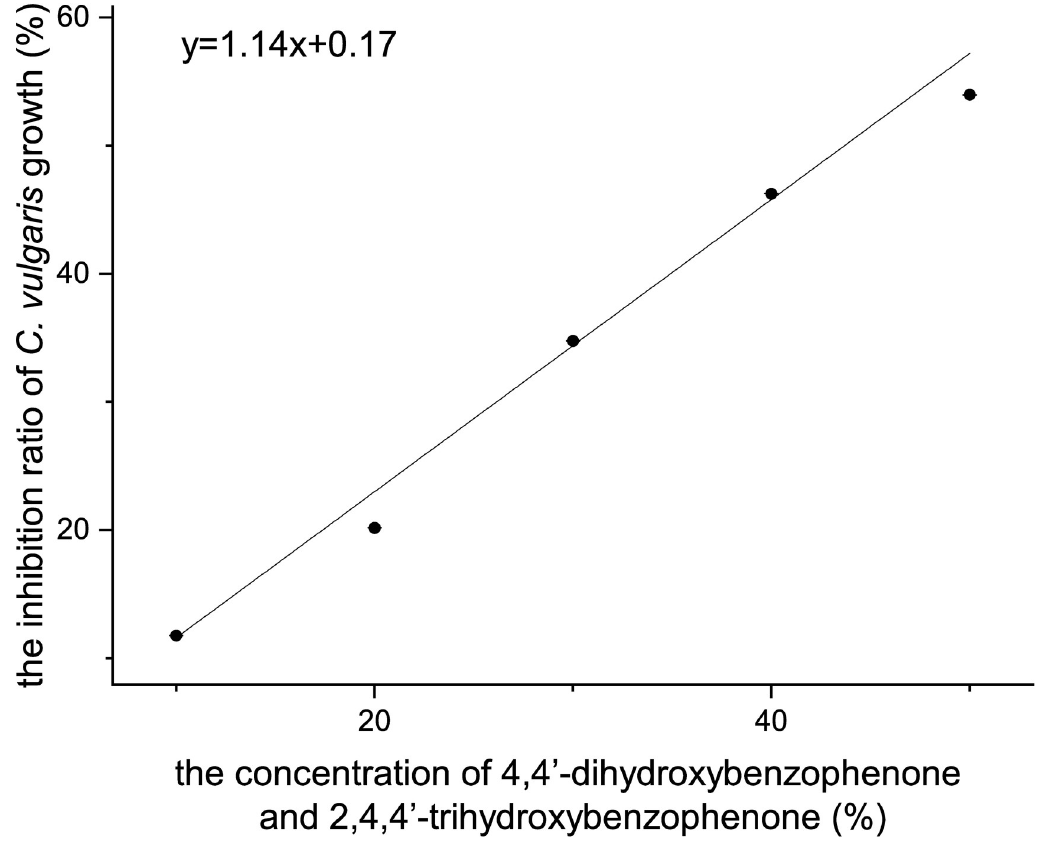
Fig 4. The inhibition ratio of C . vulgaris growth of a mixture of 4,4’-dihydroxybenzophenone and 2,4,4’- trihydroxybenzophenone.